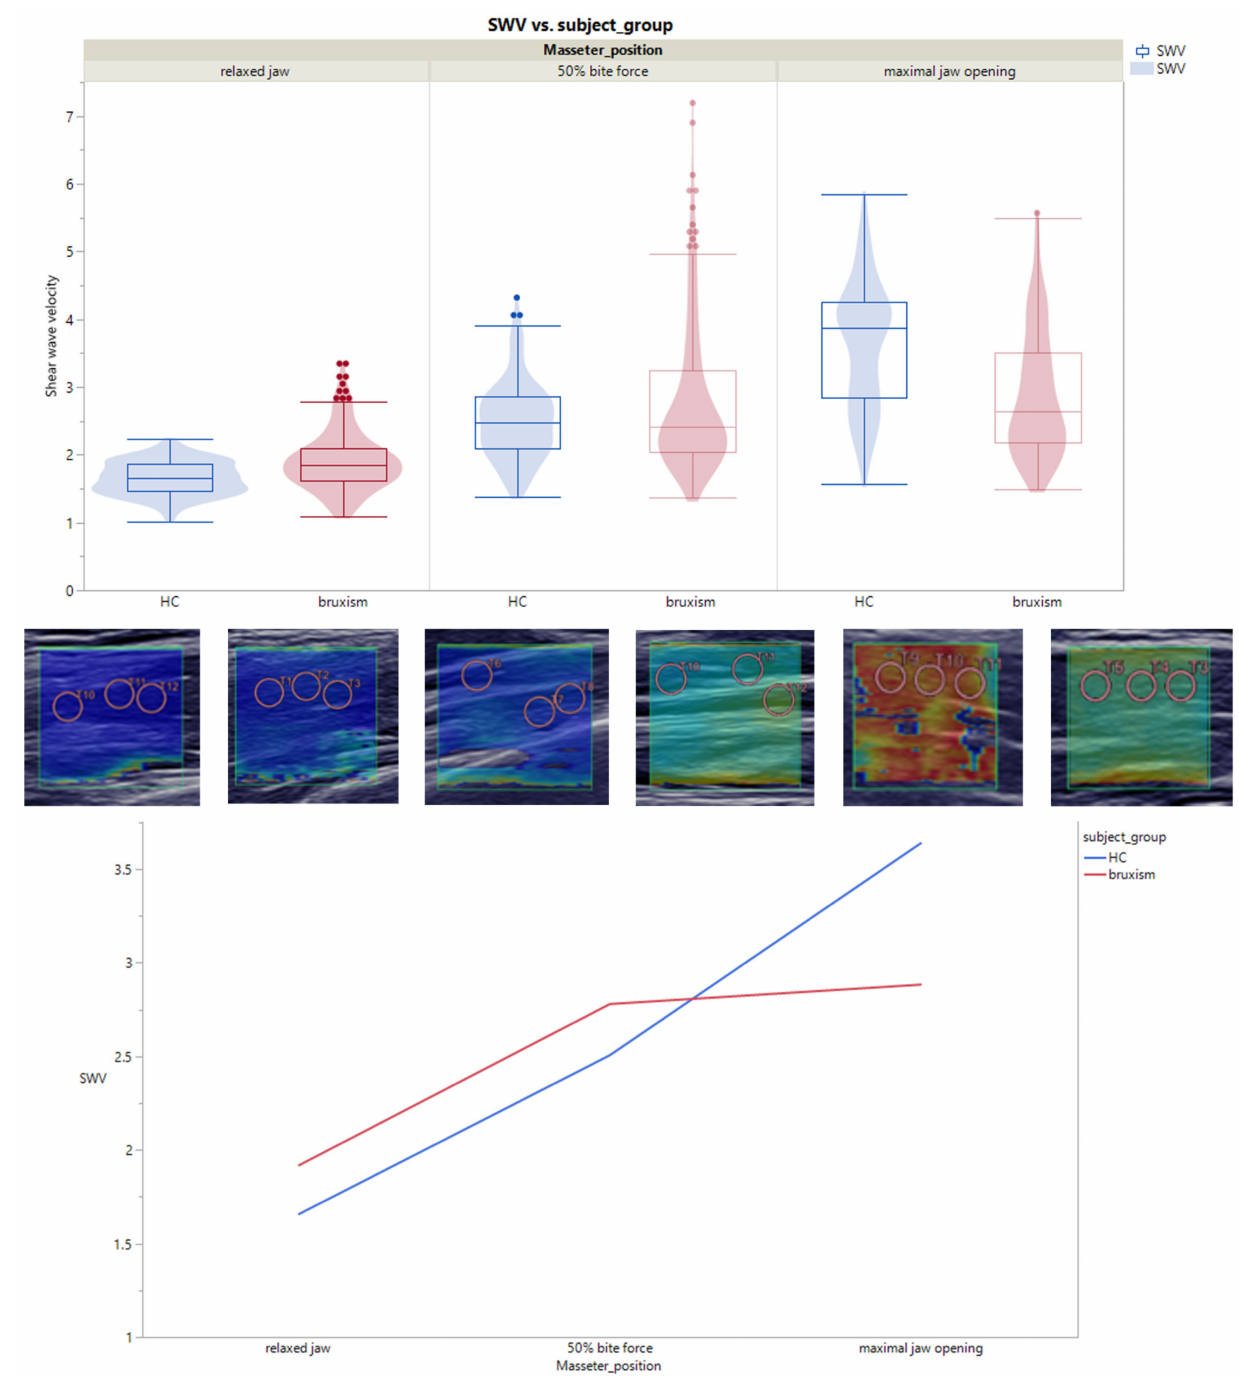
Figure 4. SWE of the musculus masseter by relaxed jaw ( p < 0.01), 50% bite force ( p = 0.722), and maximal jaw opening ( p < 0.01) with the following settings: region of interest (ROI) size: 2; ROI shape: radius; frame rate: 1; time smoothing: 0 (no time averaging); map type: speed (display shear wave speed in meters per